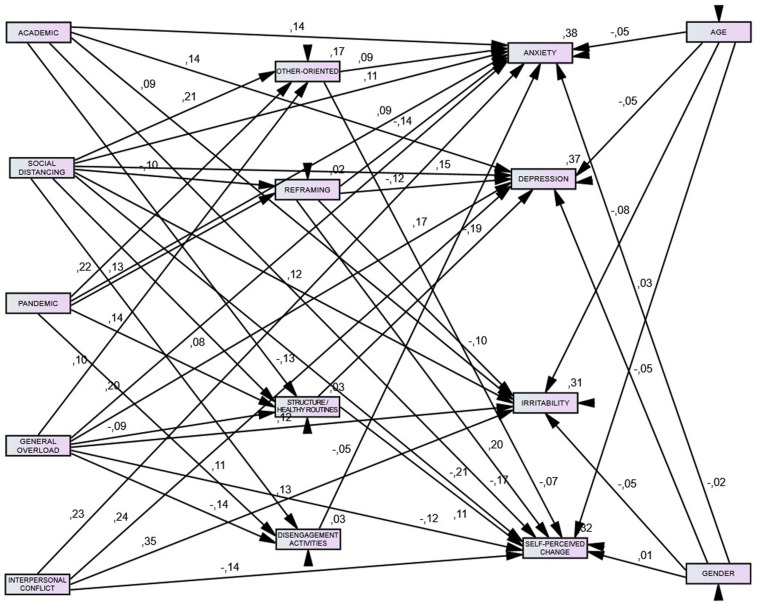
Relationship between stressors, coping, and health-related indicators. All reported path coefficients (p < 0.05) are standardized estimates. Terms of error, correlations, and covariances were omitted for clarity.